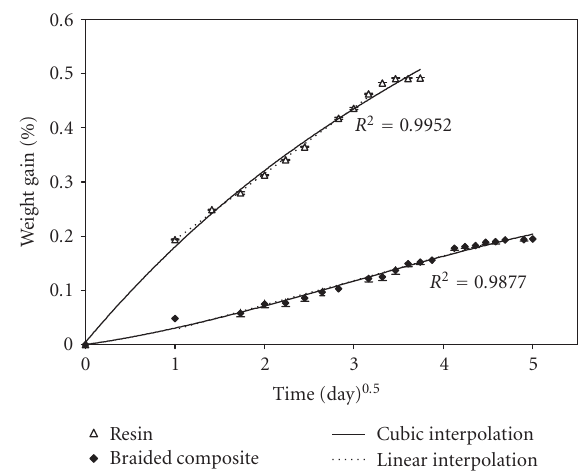
Figure 5: Weight gain as a function of the time of exposure to mois- ture for resin and